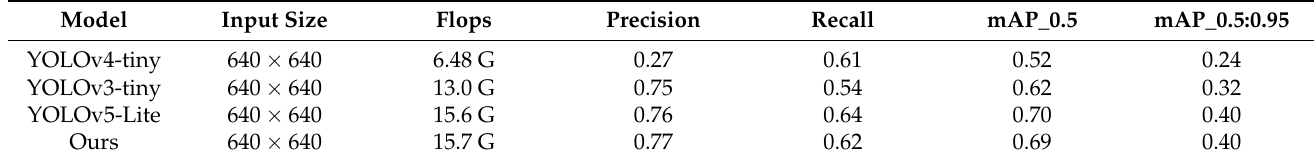
Table 3. Comparison of the detection results with other methods on the dataset WiderPerson.